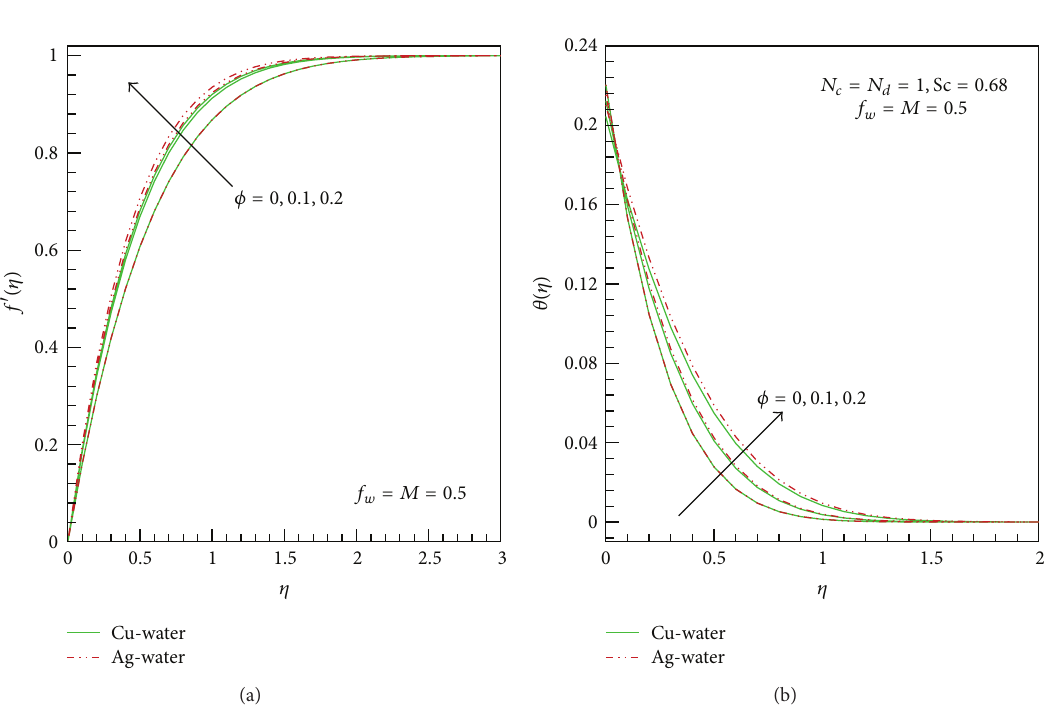
Figure 2: Effect of 𝜙 on dimensionless velocity and